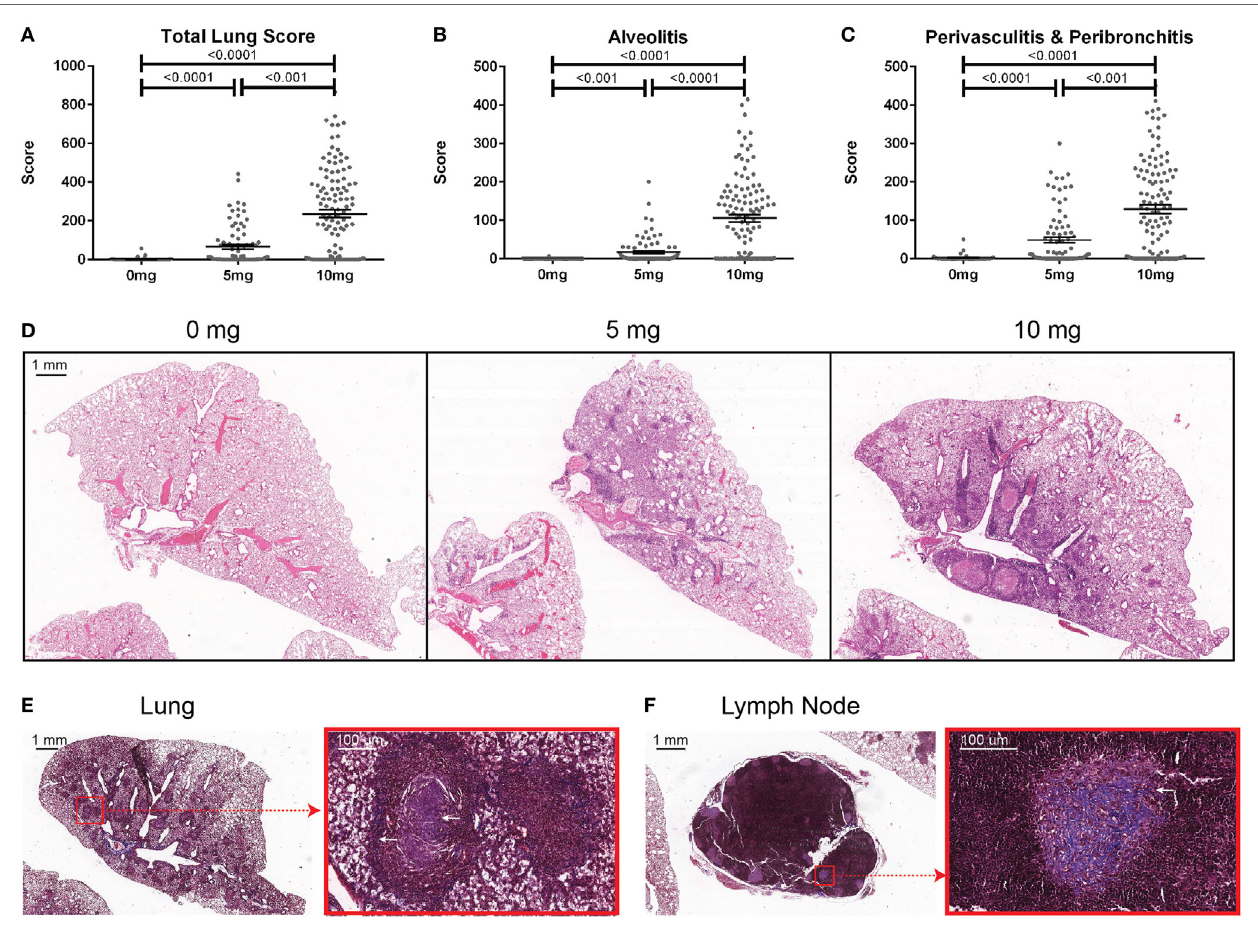
FigUre 1 | Indices of silica-induced lung pathology in diversity outbred mice. Mice were exposed transorally to 0 mg ( n = 70), 5 mg ( n = 90), or 10 mg ( n = 120) of crystalline silica in PBS for 12 weeks before H&E stained lung sections were reviewed and scored for (a) total lung score, (B) alveolitis, and (c) peribronchitis and perivasculitis. Images of slides with (D) H&E staining of the left lung lobe from mice exposed to 0 (left), 5 (middle), and 10 mg (right) of crystalline silica in PBS. Trichrome staining of the (e) left lung lobe and (F) tracheobronchial lymph node with white arrows indicating granulomas containing lattice-like fibrous connective tissue (inset with red